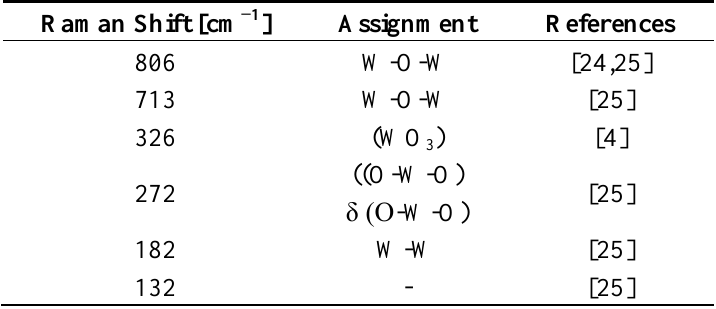
film prepared by RF magnetron 3